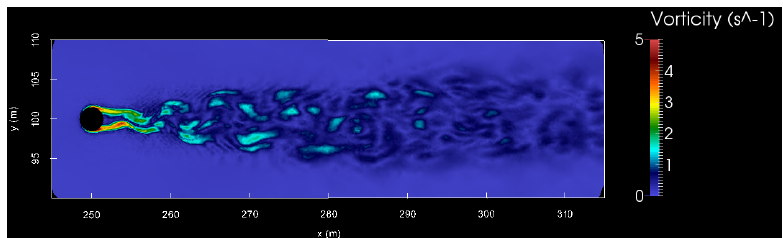
Figure 7. Horizontal slice through the vorticity field at z = 16 m and t = 900 s, showing the vorticity generated by flow past the